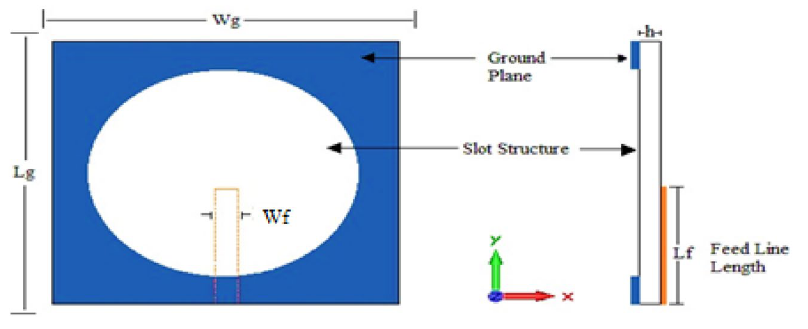
Figure 1. Antenna1